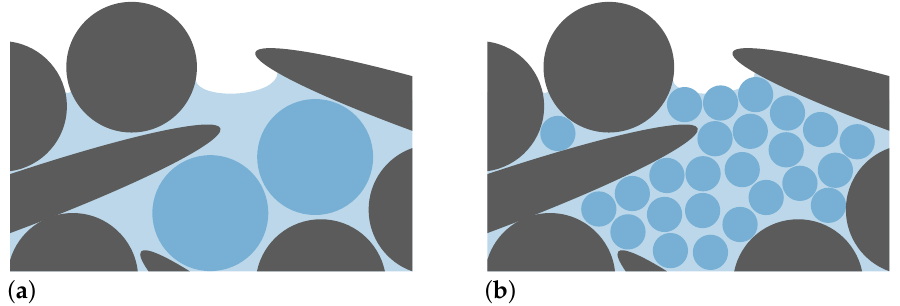
Figure 12. Subsection of Figure 2 close to the surface region where the fluid (light blue area) is repre- sented by a coarse (large blue circles in in ( a )) and by a fine (small blue circles in ( b )) fluid